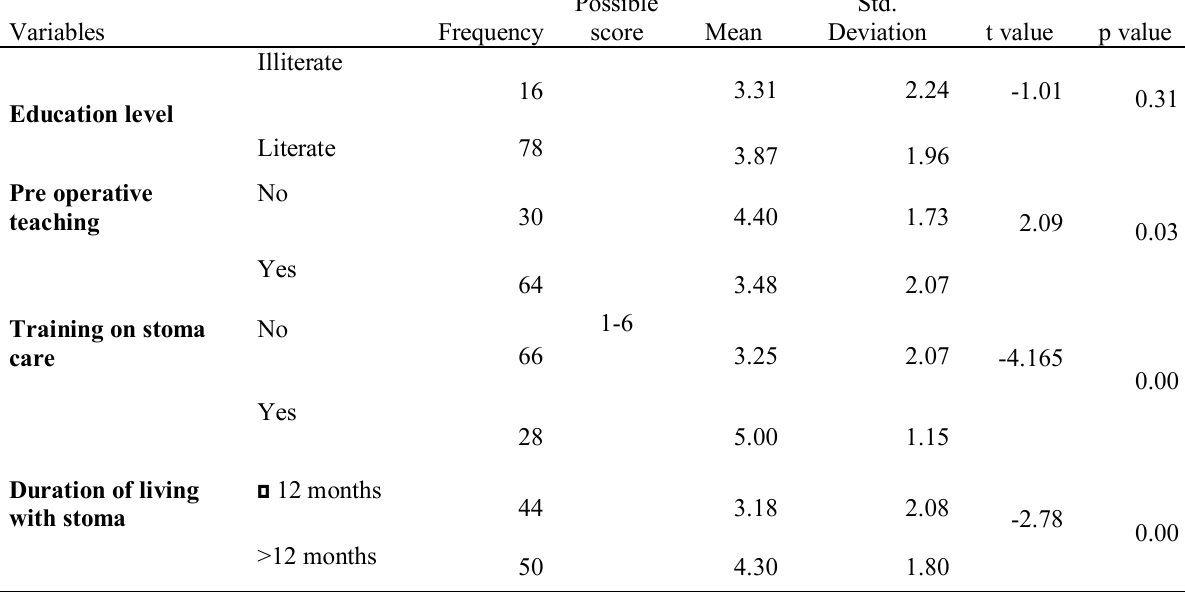
Table 10: Comparison of mean difference of Knowledge with Variables: N